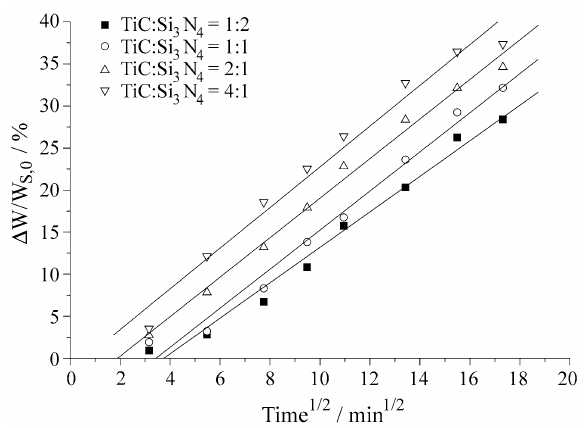
Figure 7. Same relationships as in Fig. 5 presented in parabolic coordi-